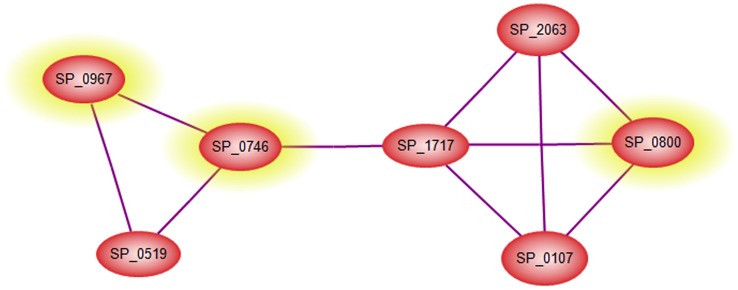
Interaction network data for connectivity of SP_0746 to SP_0800 and SP_0967 (highlighted in yellow).